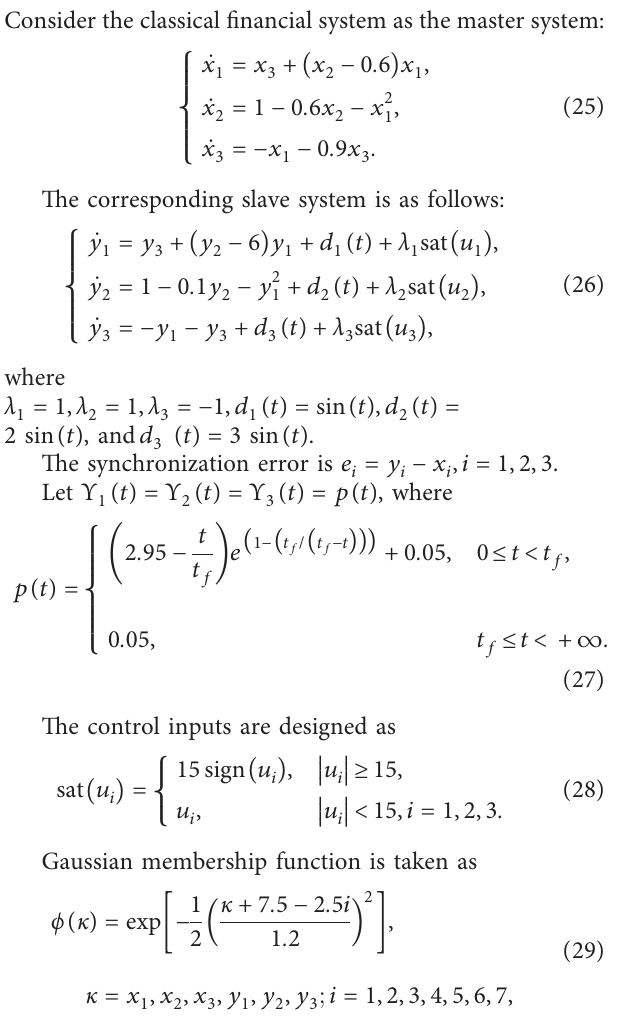
Figure 1: Trajectories of synchronization errors e t